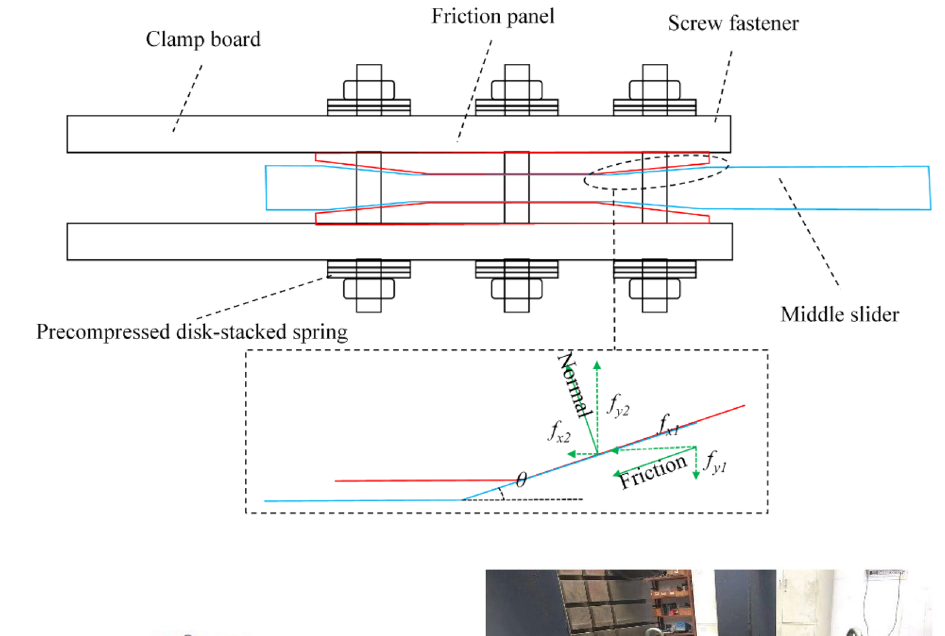
Fig. 3 a 3D model of speci- men; b experiment configura- tion